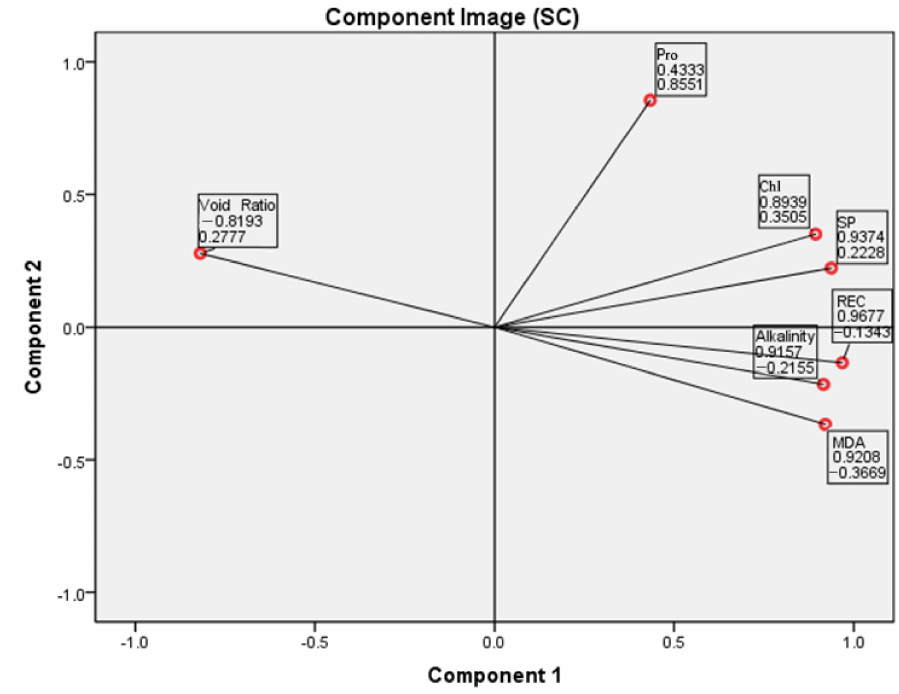
Figure 12. Distribution of the weights of different indexes in the first and second principal components in the SC group.